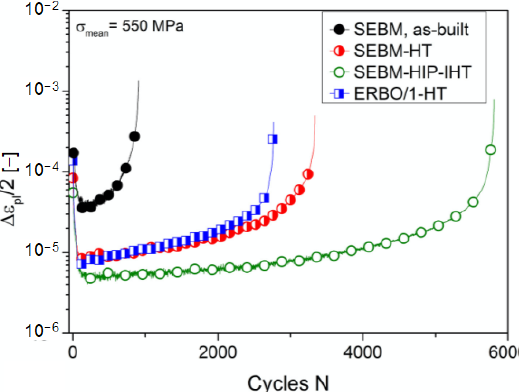
Figure 24. Results of low cycle fatigue (LCF) experiments on different heat treated specimens of nickel-based SX superalloy [70] .